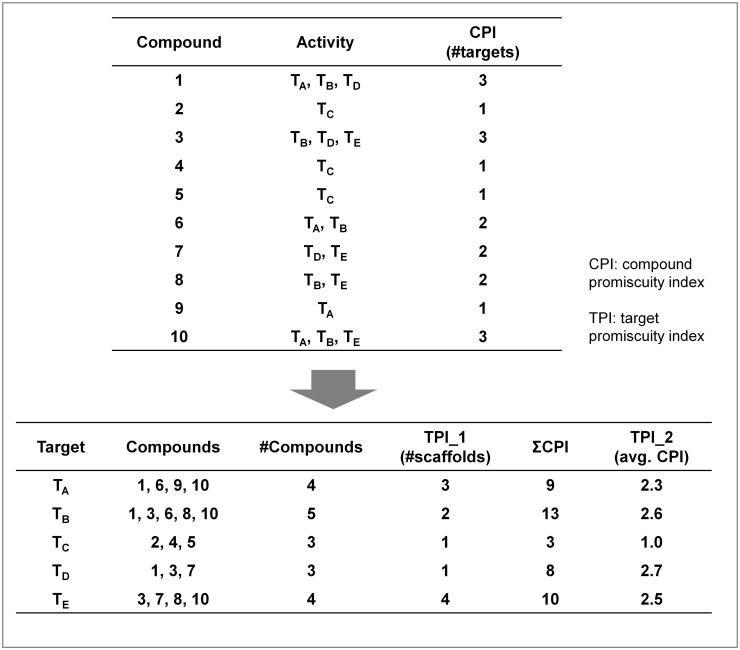
Calculation of first- and second-order target promiscuity indices.Shown is a workflow that illustrates how first- and second-order target promiscuity indices are calculated. On the basis of compound activity data, the activity profile of a compound is generated by collecting all available target annotations (top). Accordingly, for each compound, the number of targets it is active against is counted to yield the compound promiscuity index (CPI). Then, all compounds active against the same target are grouped (bottom). For each target, the number of unique scaffolds contained in its ligands is determined as the first-order target promiscuity index (TPI_1). Furthermore, CPI values of all compounds interacting with a given target are summed and the average CPI value is calculated as the second-order target promiscuity index (TPI_2).